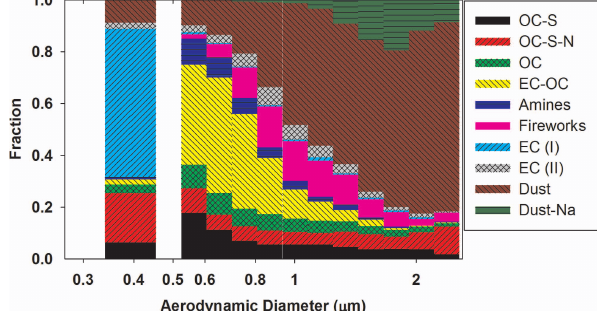
Fig. 7. The proportion of particles of each type, based on particle number, as a function of particle